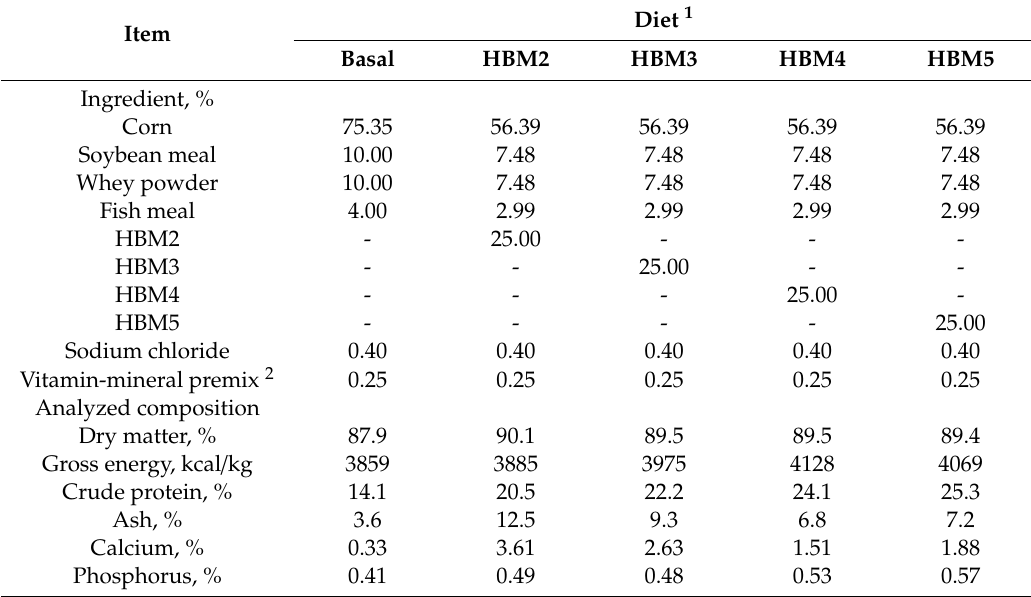
Table 3. Ingredients and chemical compositions of the experimental diets containing various hatchery byproduct mixtures (HBMs), as-fed basis (energy digestibility